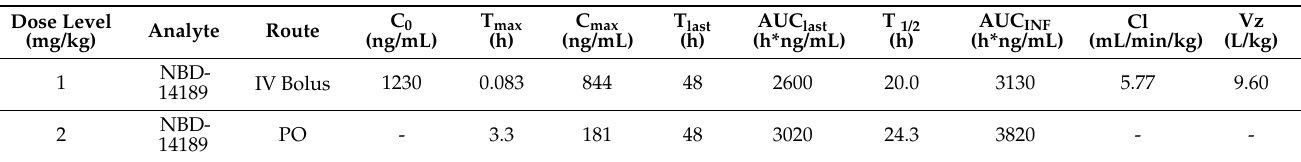
Table 2. Summary of NBD-14189 pharmacokinetics parameters following a single IV bolus or PO administration of NBD-14189 in male Beagle